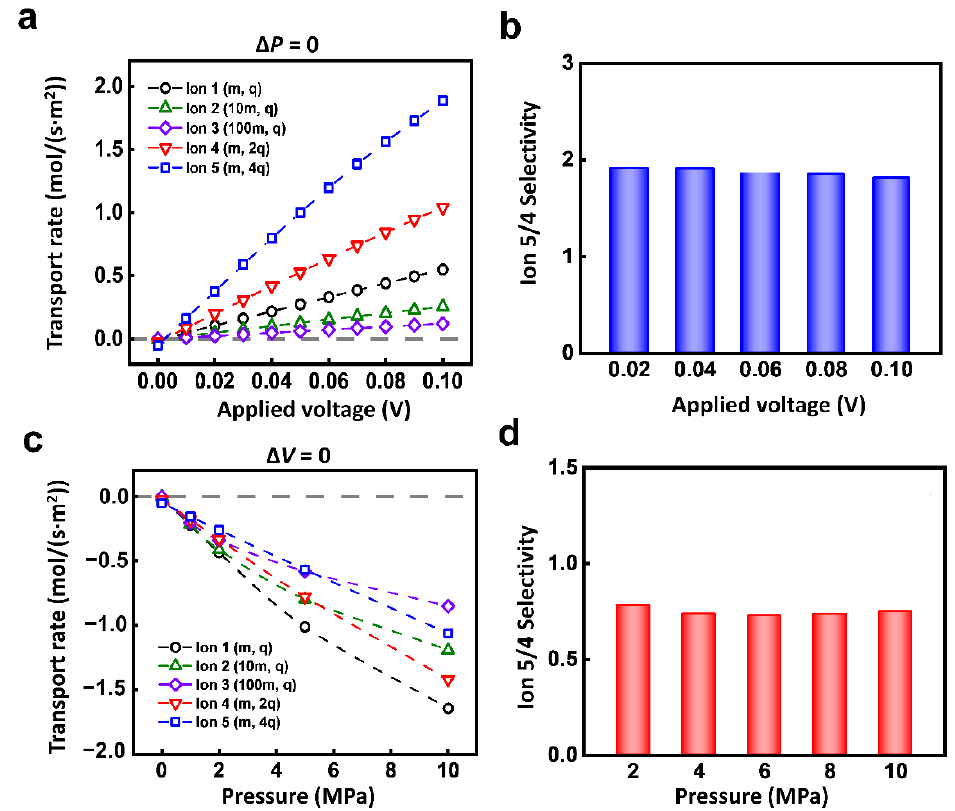
Figure 3. The ion transport under a single physical field. ( a ) Different charged ions have different responses to the electric field. ( b ) The selectivity ratio of Ion 4 and Ion 5 under electric field. ( c ) Different ions have different responses to hydraulic pressure. ( d ) The selectivity ratio of Ion 4 and Ion 5 under hydraulic pressure.